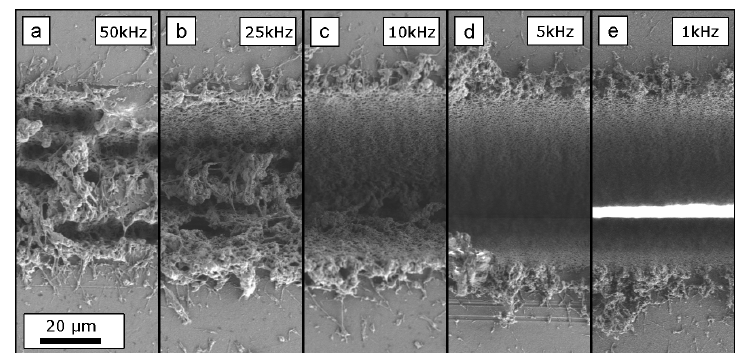
Figure 5. Upper and lower edge of rectangle cuts in a 127 µ m-thick FEP VDA foil. The cuts were processed with a constant total energy input, hence, decreasing pulse repetition rates (( a ) 50 kHz; ( b ) 25 kHz; ( c ) 10 kHz; ( d ) 5 kHz; ( e ) 1 kHz) whilst increasing the number of scan repetitions (corresponding to increasing machining times). The foil thickness is cut through only for 50kHz and 50 scan repetitions as multiple scan repetitions enable more efficient material removal, compared to few scan repetitions and high pulse repetition rates. The scale bar indicated in ( a ) applies to all